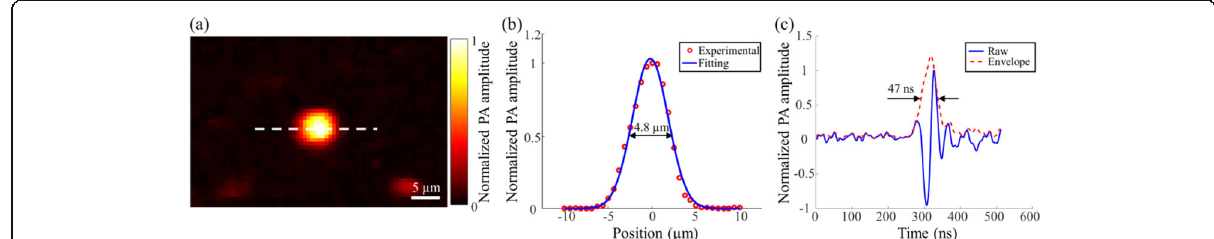
Fig. 2 Spatial resolution measurement. a An LD-based PAM image of a carbon particle; b Lateral resolution measurement. The red circles are the experimental data along the white dotted line in Fig. a . The blue solid line is a Gaussian fitting function; c Axial resolution measurement. The red dotted line represents the envelope of the A-line signal of the central position of the carbon particle in Fig. a